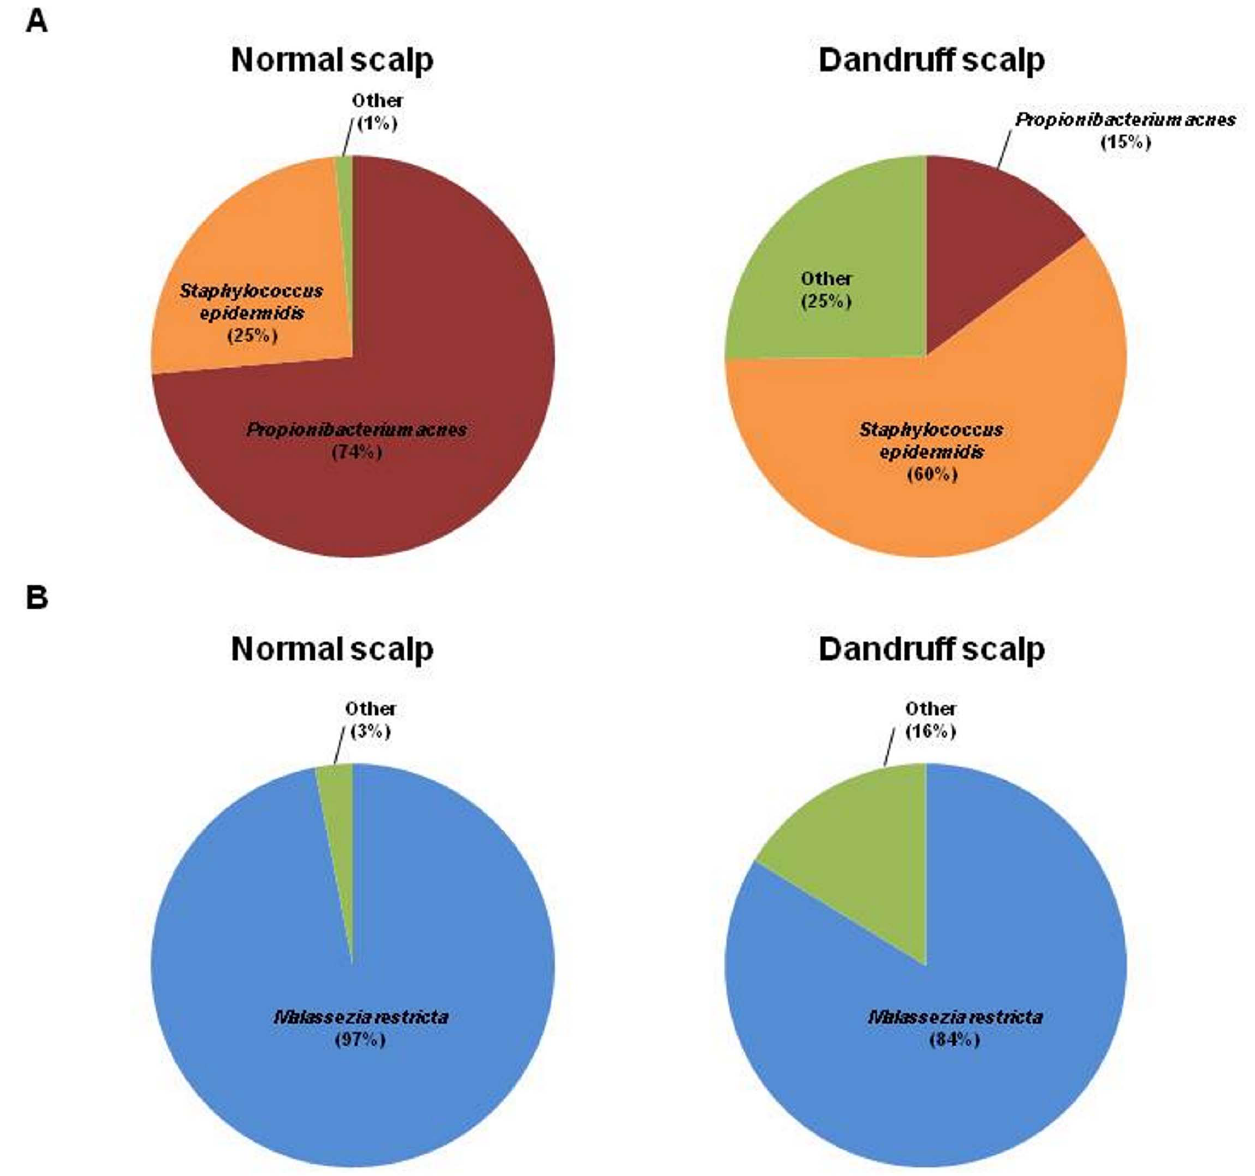
Figure 1. Distribution of bacterial and fungal species in 10-normal and 9-dandruff scalps from set-1. (A) Distribution of 2,122 sequences ( , 1500 bp) of 16S rDNA and (B) 2,225 sequences ( , 1500 bp) of ITS-28S rDNA between the normal scalps and dandruff–affected scalps. Results are presented as the percent (%) of total sequences recovered per species. The predominant species are presented on this figure, while the detailed list of the sequences identified is presented in the Supporting Information (Table S1 and S2).